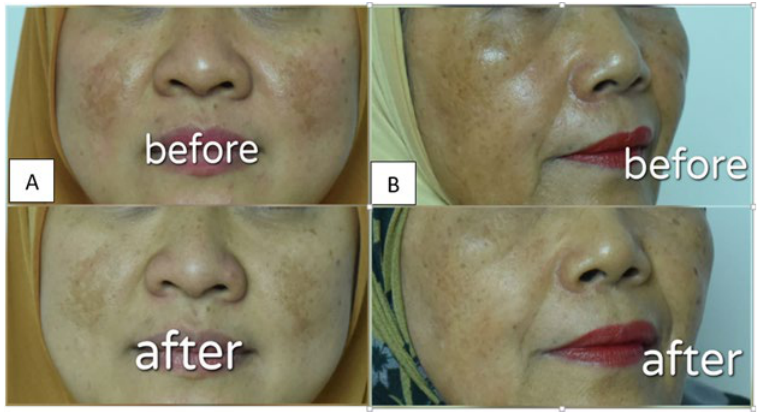
Figure 6. Photographs of volunteers ( A ) before and ( B ) after application of the α -mangostin-loaded USUC to the face for two weeks.